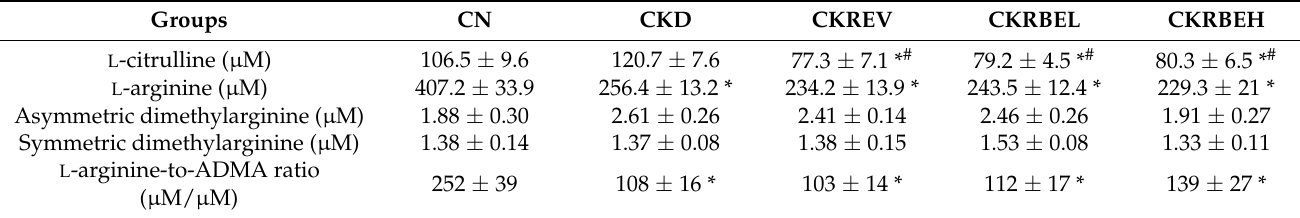
Table 3. Plasma levels of NO-related parameters.